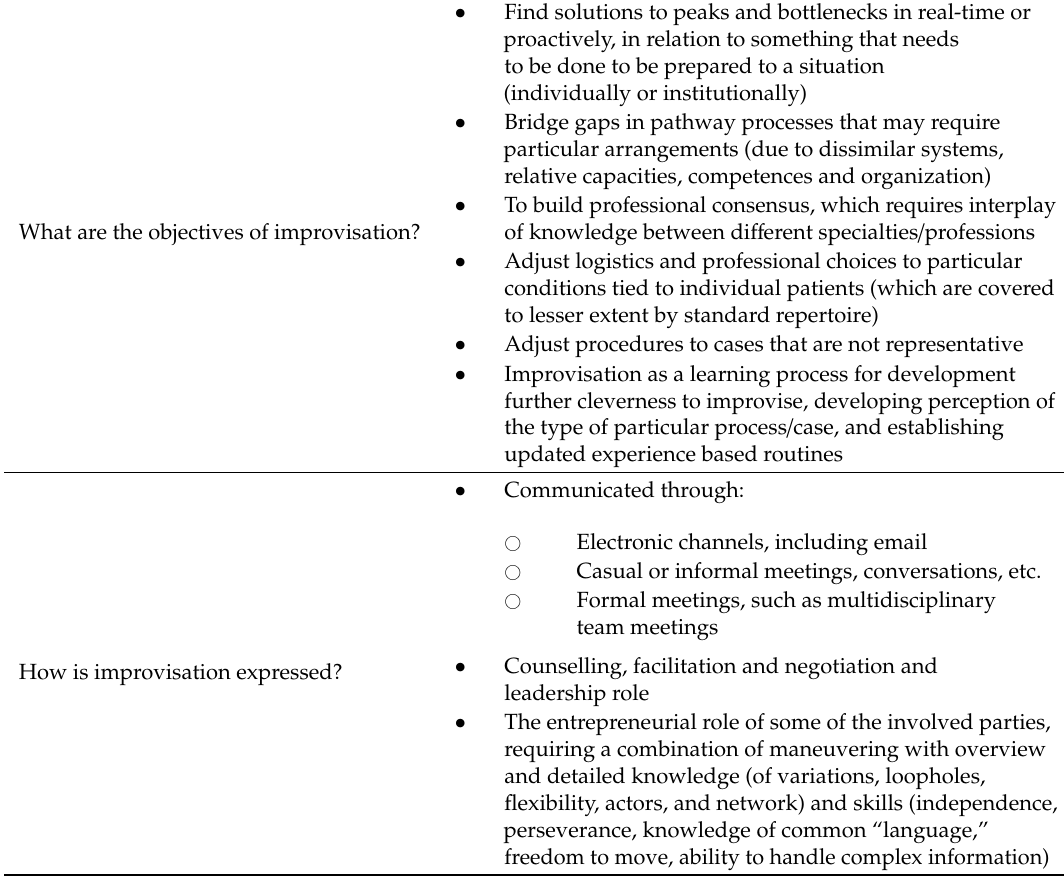
Table 6. Improvisation in relation to coordination of patient